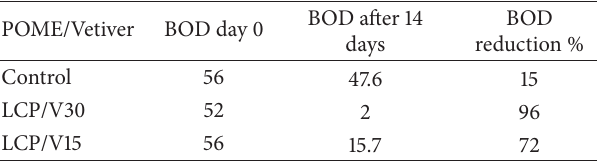
Table 5: Reduction of COD in high concentration POME with different Vetiver density.